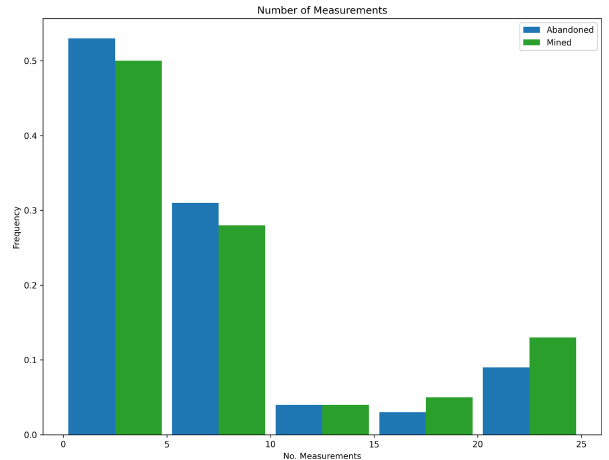
Figure 21. Measurement histogram, POMCPOW with action con- straints, single body with variable location. This figure shows a his- togram of the number of measurements taken by the POMCPOW solver over all Monte Carlo trials. The trials were limited to a max- imum of 25 measurements.